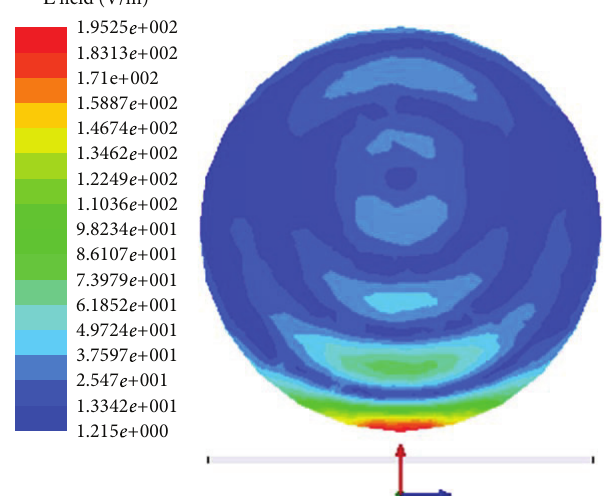
F 6: �-�eld strength distribution in one-layer human head model at 900MHz.